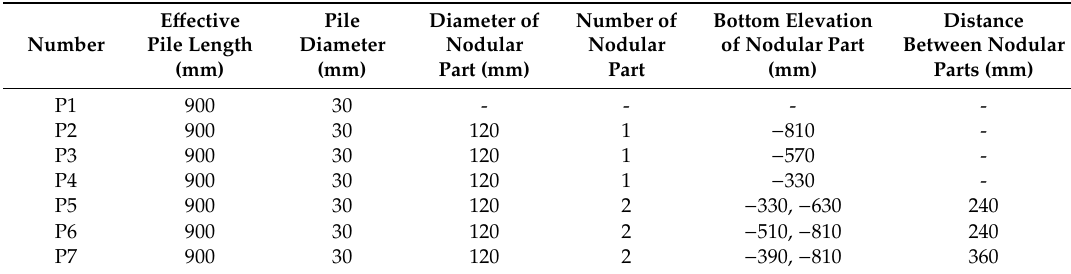
Table 1. The configuration of nodular